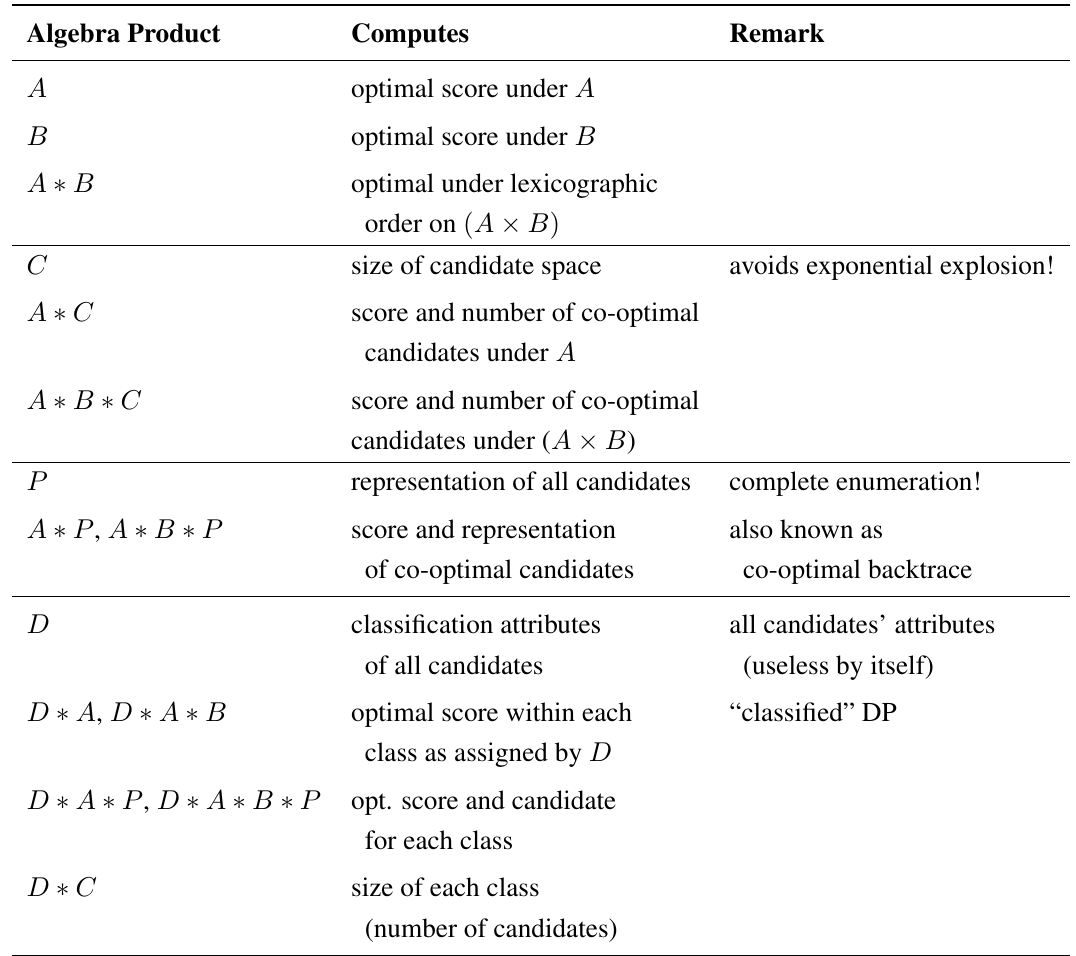
Table 2. Various uses of the lexicographic product, as given in Definition 7, with different kinds of